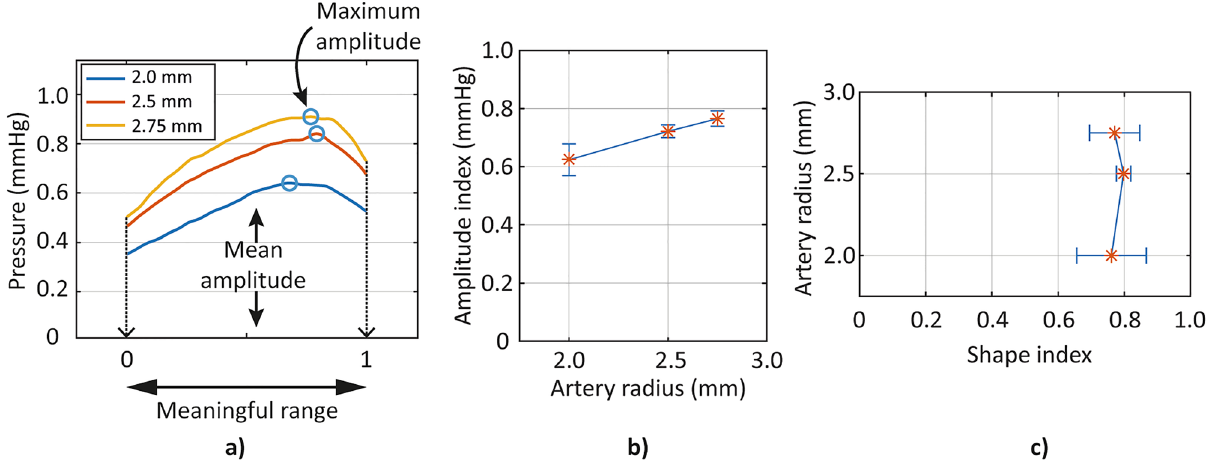
Figure 7. Correlation analysis between inner artery radius and oscillometric signal—Experiment with phantoms. ( a ) Oscillometric signals (envelope only, time-axis normalized to the meaningful range) obtained from the experiment with different artery radius, ( b ) Amplitude index (ordinate) with various artery radius, ( c ) Shape index (abscissa) with various artery